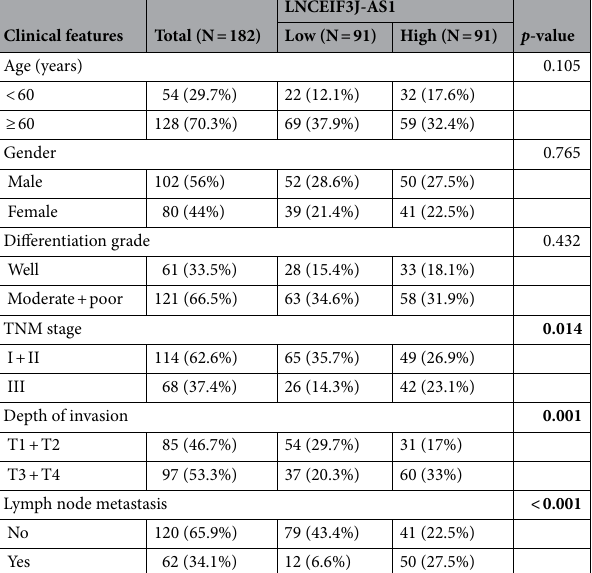
Table 1. The correlation between clinicopathological parameters and LNCEIF3J-AS1 expression in human esophageal cancer. Pearson chi-square test was used for comparison between subgroups. Bold values indicate p -value <